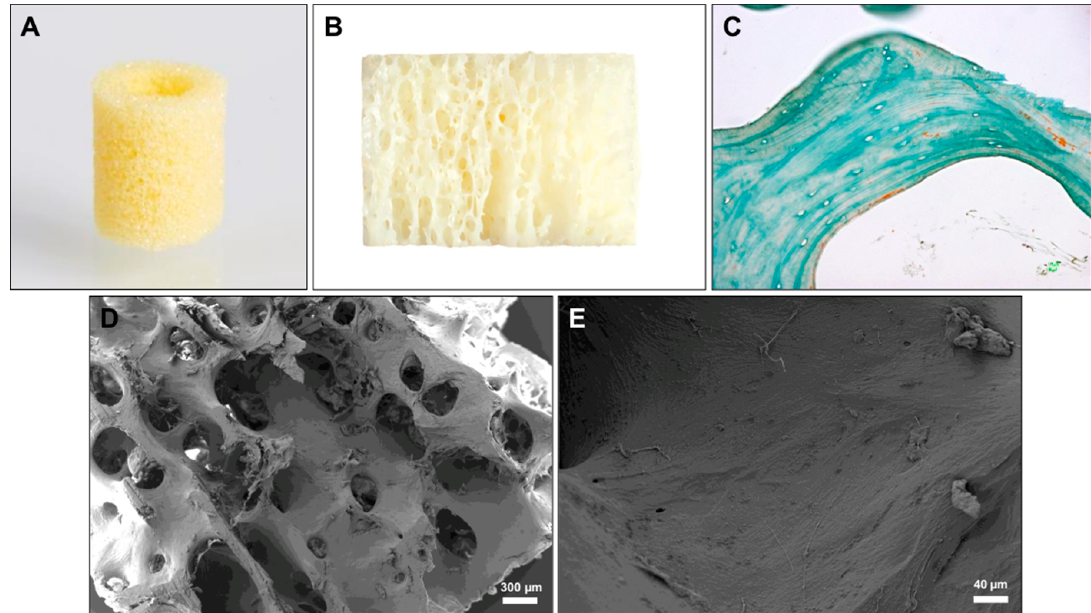
Figure 1. ( A ) Image of the bone ring that shows its porous structure. ( B ) Profile of the bone ring showing the trabecular subarrangement. ( C ) Exemplary histological image of the former bone matrix indicating its lamellar architecture and its complete clearance from cells as well as the matrix-associated collagen fibers (arrow) (Masson Goldner staining, 400x magnification, scale bar = 20 µm). ( D ) Exemplary SEM image that shows the lamellar structure of the bone substitute material and the macro- and micro-porosity (40x magnfication). ( E ) SEM image of the material surface that shows the clearance of the osteocyte lacunae and the fibre-like surface pattern (200x magnification).